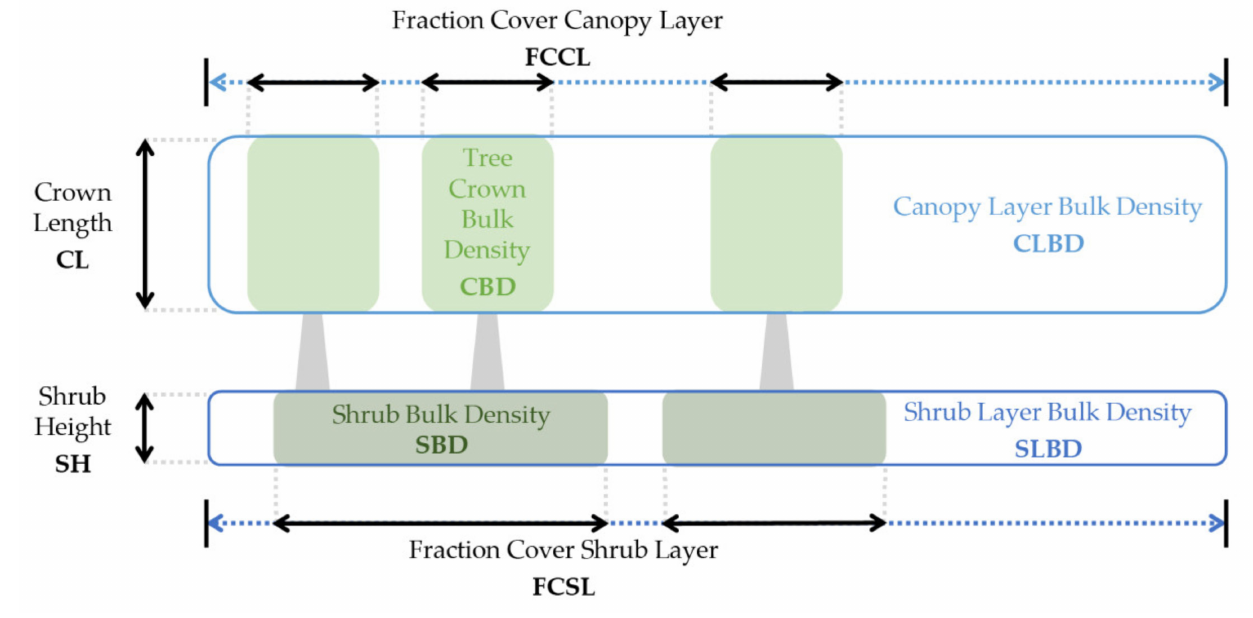
Figure 1. Schematic representation of a two-layer forest, including a tree canopy layer with height or length (CL) and a shrub layer with height